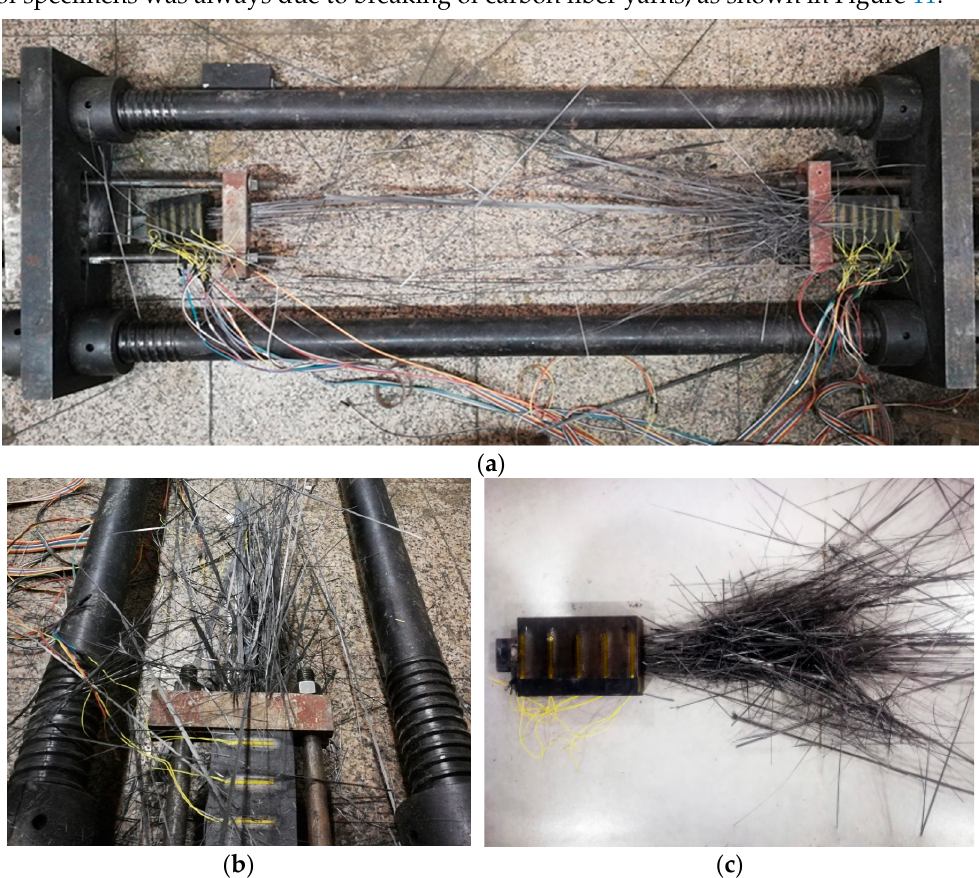
Figure 11. Typical fracture forms of CFRP plates. ( a ) testing apparatus, ( b ) detail view of one end of the testing apparatus, ( c ) anchorage.